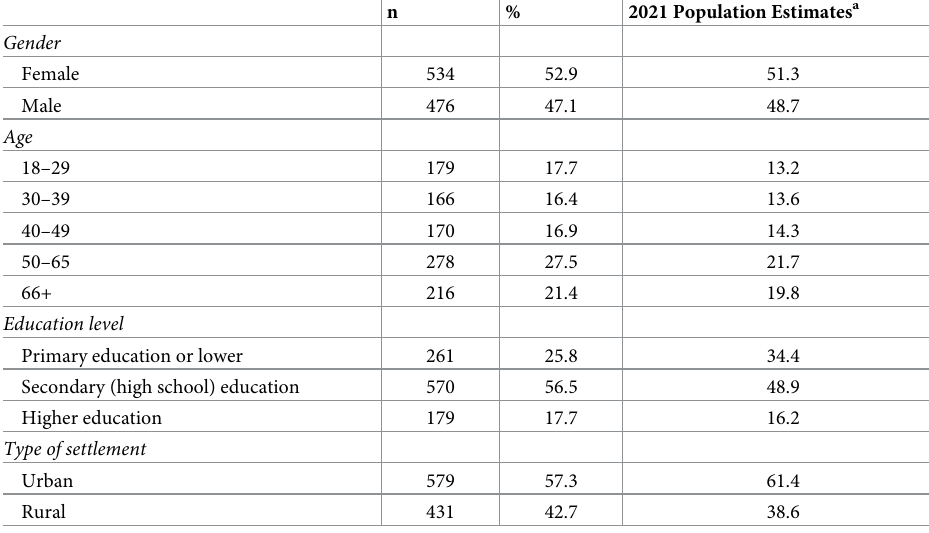
a The percentages shown are population estimates for 2021 according to the Statistical Office of the Republic of Serbia, except the education estimates, which are based on the available 2011 census data. Those percentages do not add up to 100 due to missing